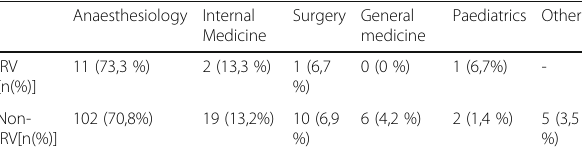
Table 1 (abstract 000230). Specialist discipline of the surveyed emergency physicians